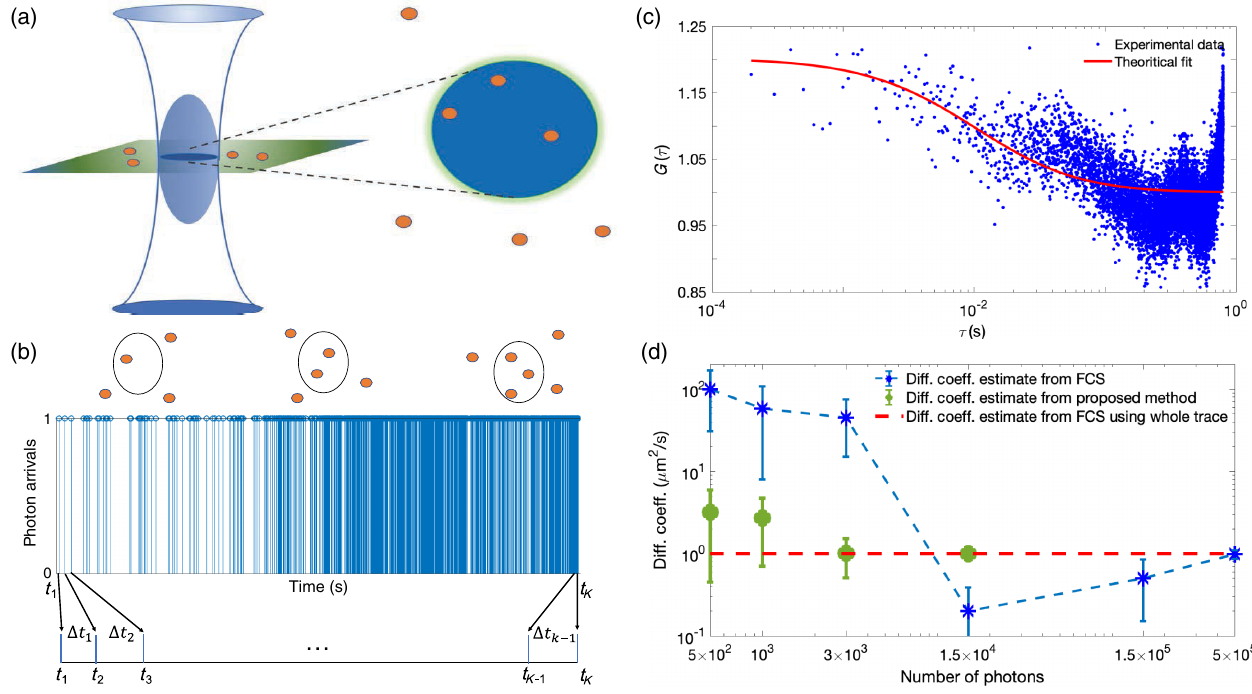
FIG. 1. Photon arrival times can characterize dynamical properties of molecules on fast, photon-detection, timescales. (a) Schematic of an illuminated confocal volume (blue) with fluorescent molecules emitting photons based on their location within that volume. (b) Synthetic trace containing ≈ 1500 photon arrivals produced by four molecules diffusing at 1 μ m 2 = s for a total time of 30 ms under background and molecule photon emission rates of 10 3 photons = s and 4 × 10 4 photons = s, respectively. (c) Autocorrelation curve G ð τ Þ of the trace in (b), binned at 100 μ s. On account of the limited data available in the trace, any reasonable fit is impossible. Normally, in FCS analysis, much longer traces are used to generate smoother G ð τ Þ that are fitted to determine a diffusion coefficient. In Fig. 14 of the Appendix, we show that the quality of the fit does not improve considerably by fitting to a semilogarithmic curve. (d) Comparison between diffusion-coefficient estimates using our proposed method (detailed later) and FCS as a function of the number of photon arrivals in the analyzed trace. Since by 1 . 5 × 10 4 photon arrivals our method has converged, we avoid analyzing larger